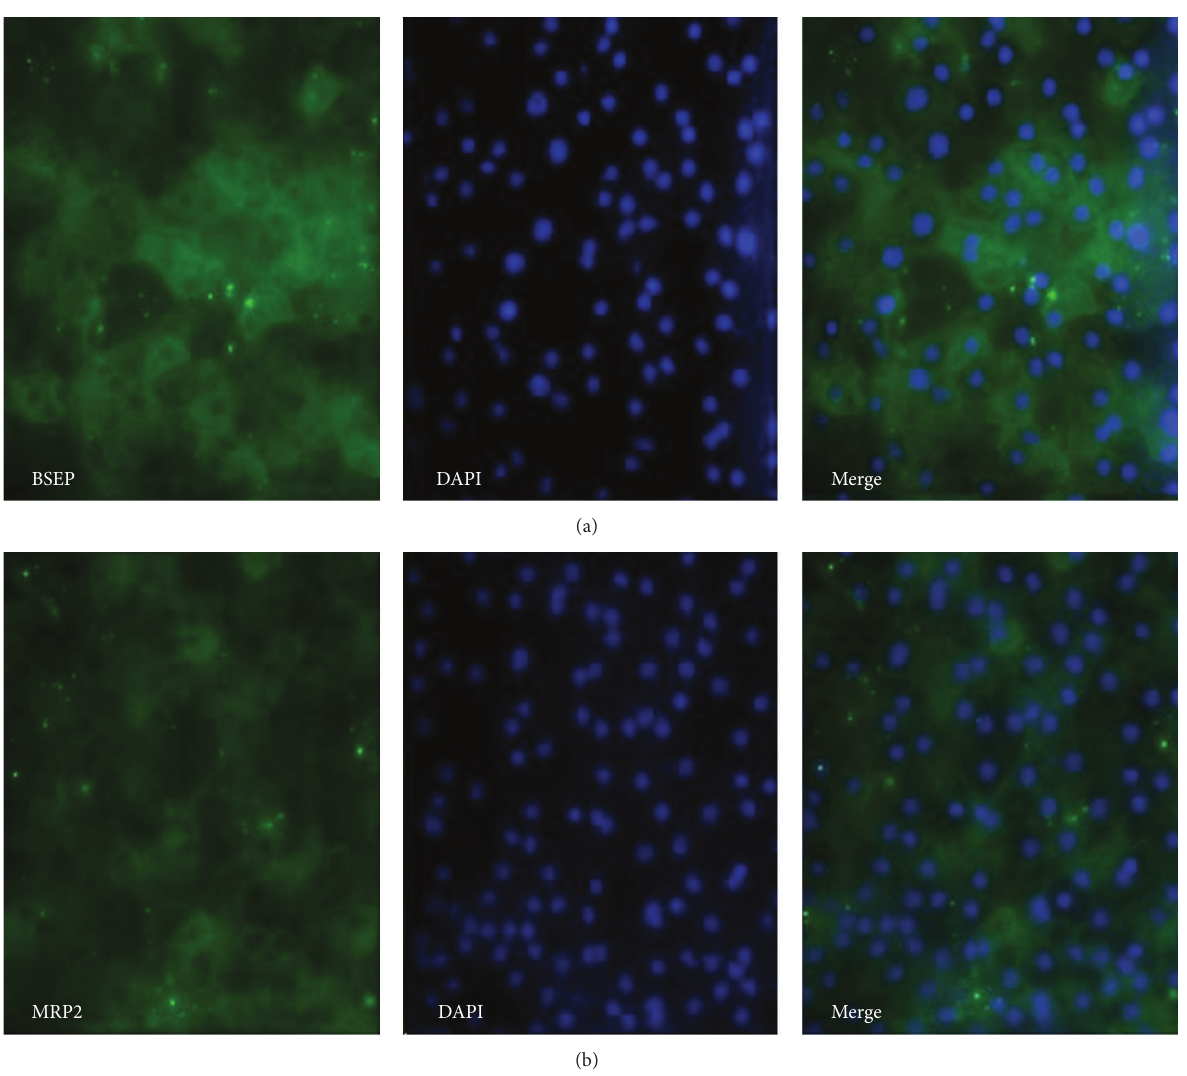
Figure 17: Representative micrographs illustrating the expression of drug transporters at day 29 of the hepatic differentiation. Magnification: 20x. Panel (a) shows stainings for BSEP in P11025 cell line. Panel (b) shows stainings for MRP2 in SA121 cell